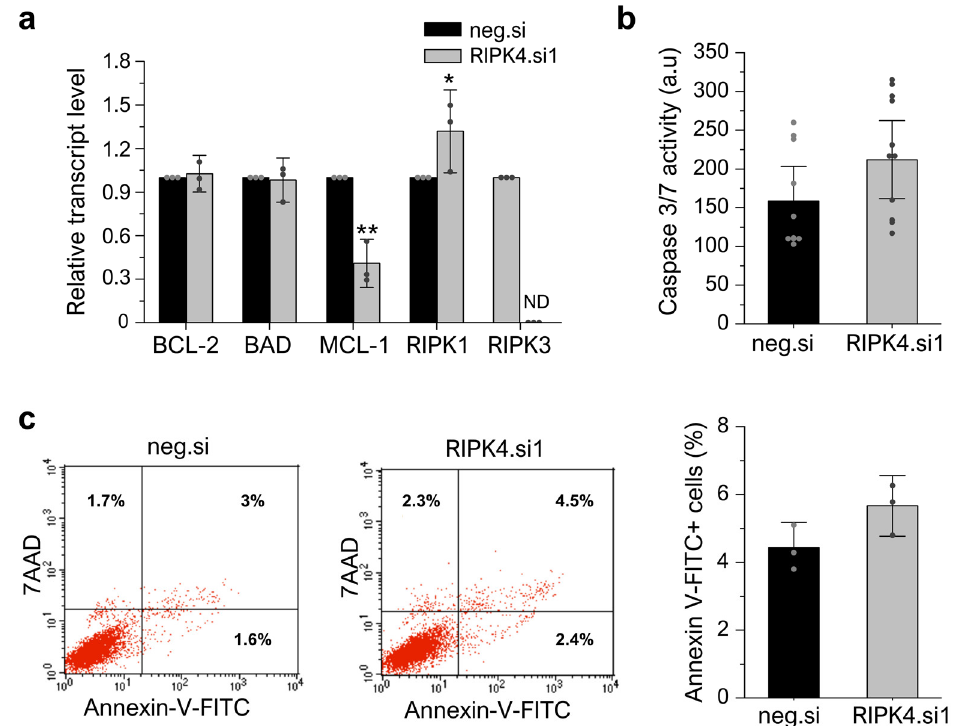
Figure 9. Silencing of RIPK4 using siRNA has no impact on apoptosis or necroptosis in WM266.4 cells measured 48 h after transfection. ( a ) Transcript levels of BCL-2, BAD, MCL-1, RIPK1, RIPK3 48 h after transfection with RIPK4.si1 or neg.si normalized to GAPDH. ND—not detected. ( b ) Caspase activity 3/7. ( c ) Representative Annexin V-FITC/7AAD double staining and FACS analysis (left). Annexin V-FITC positive cells (sum of Ann+/7AAD- and Ann+/7AAD+; right). Each bar represents the mean ± SD of three biological replicates. All RIPK4.si transfected cells were compared with neg.si (scrambled control) samples. Statistical analysis was performed using the Student’s t -test. * p < 0.05, ** p < 0.01 was considered